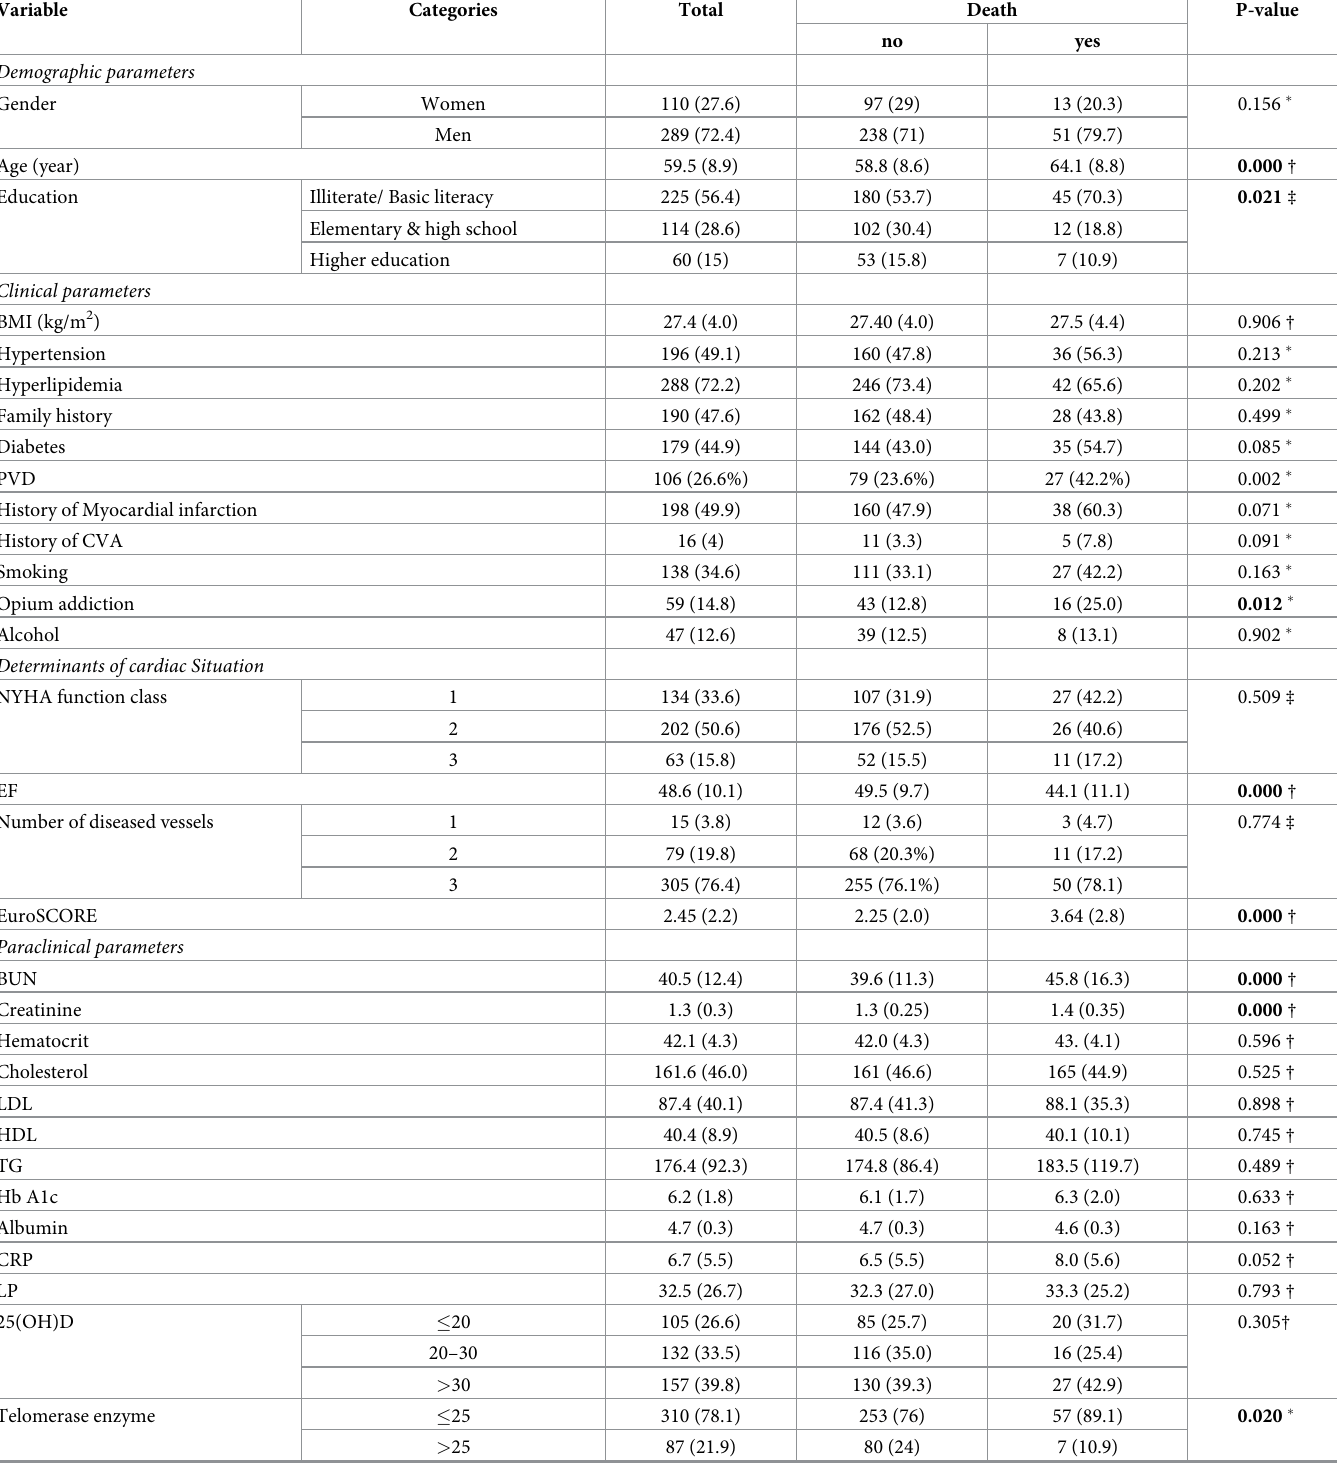
Table 1. Demographic, clinical and preclinical parameters at the beginning and their relationship with 10-year